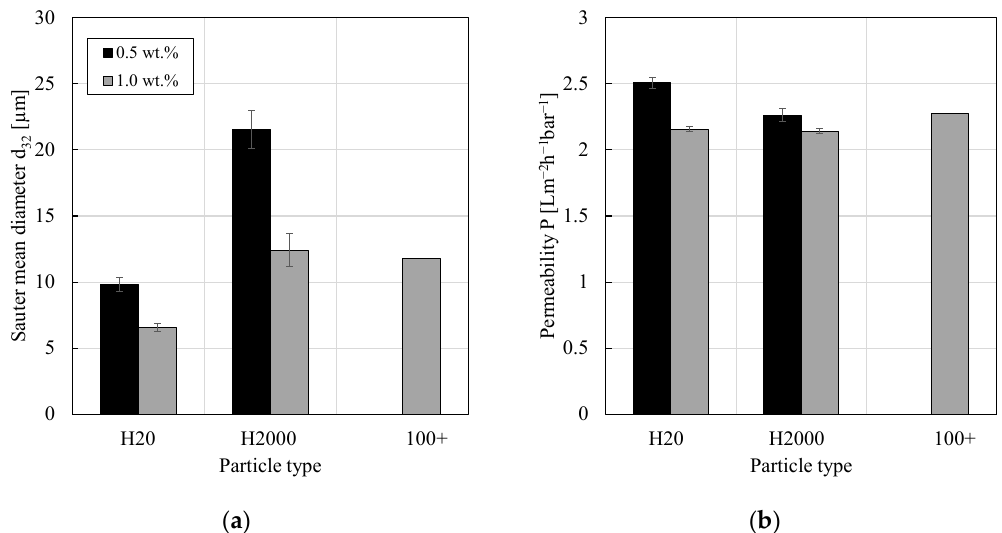
Figure 2. ( a ) Sauter mean diameter and ( b ) permeability of w/o PEs stabilized by either 0.5 or 1.0 wt.% of different silica particles. The PE stabilized by particle type 100+ was investigated once and used for a hydroformylation reaction (with subsequent concentration filtration experiment). All other emulsions were prepared without the catalyst-ligand complex and investigated at least in duplicate pressure stepping experiments. Mean values are shown and error bars represent the standard deviation. For comparison, the permeability of pure 1-dodecene was 3.58 ± 0.60 Lm − 2 h − 1 bar − 1 . Drop size distributions for particle types H20 and H2000 were already published in [14] and the Sauter mean diameter for particle type 100+ was published in [18].